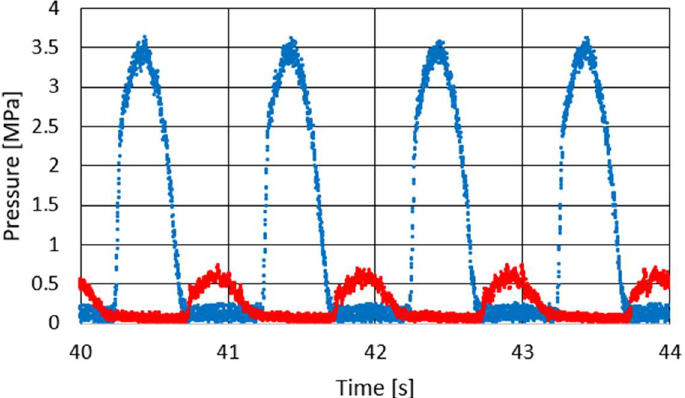
Figure 6. Results of pressure changes on PZV valve channels during experimental testing of a PZD damper with kinematic excitation at a frequency of 1 Hz, amplitude of 0.030 m, voltage of 150 V. The red curve represents the changes of the pressure in channel linked with the chamber below the piston while the blue line represents the pressure in the channel linked to the chamber above piston.